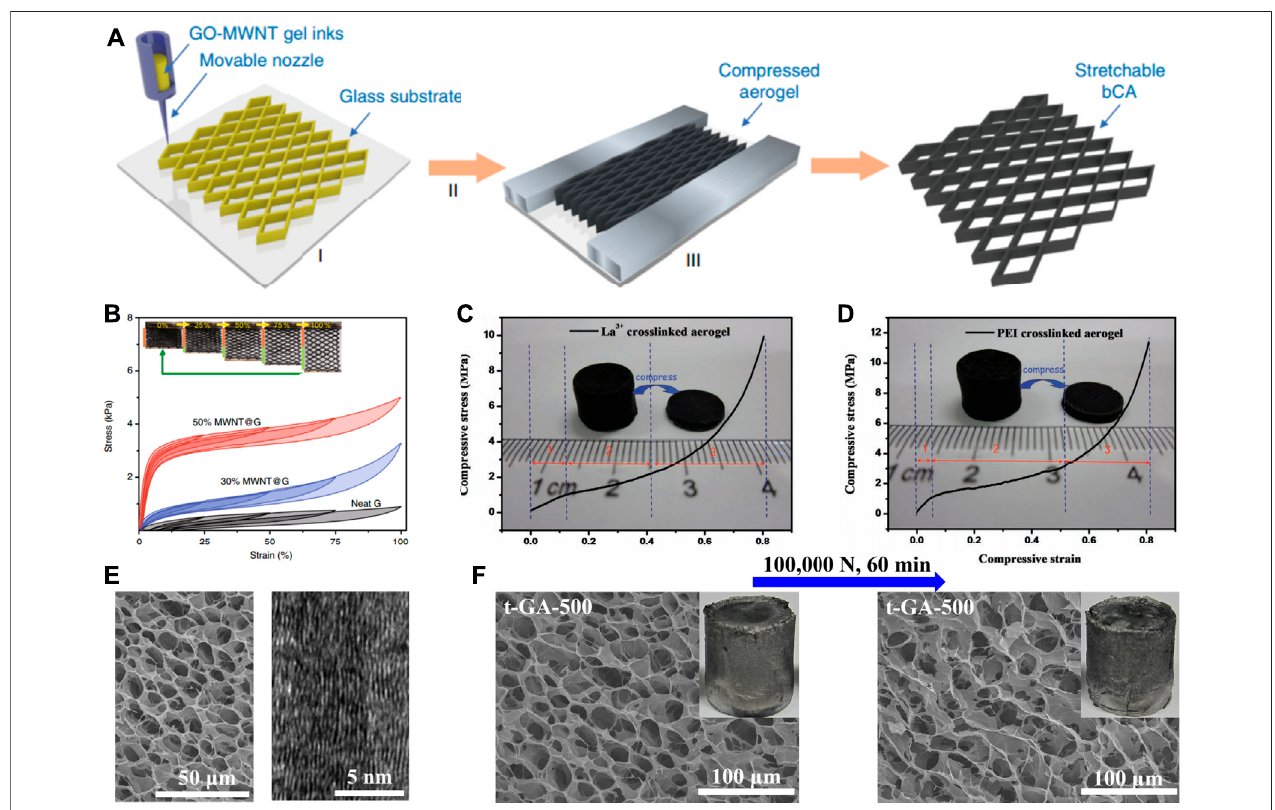
FIGURE 4 | (A) Schematic illustration of the hierarchical synergistic assembly for fabrication of binary carbon porous material through the 3D printing technique (Guo et al., 2018). (B) Stress – strain curves of 3GAs with 25, 50, 75, and 100% tensile strains (Guo et al., 2018). Compressive stress – strain curves of the La 3+ - (C) and PEI- (D) crosslinkedGOporousmaterials(Guoetal.,2018). (E) SEMimageandHRTEMimageof3GAs(Lietal.,2018b). (F) SEMimageanddigitalimageof3GAsbefore and after compression under 100, 000 N for 60 min (Li et al.,